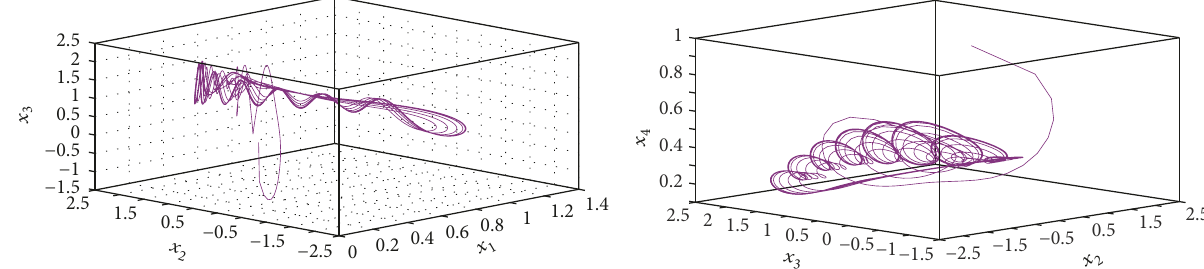
Figure 15: 3D phase portraits of the FPGA implemented FOSG system.